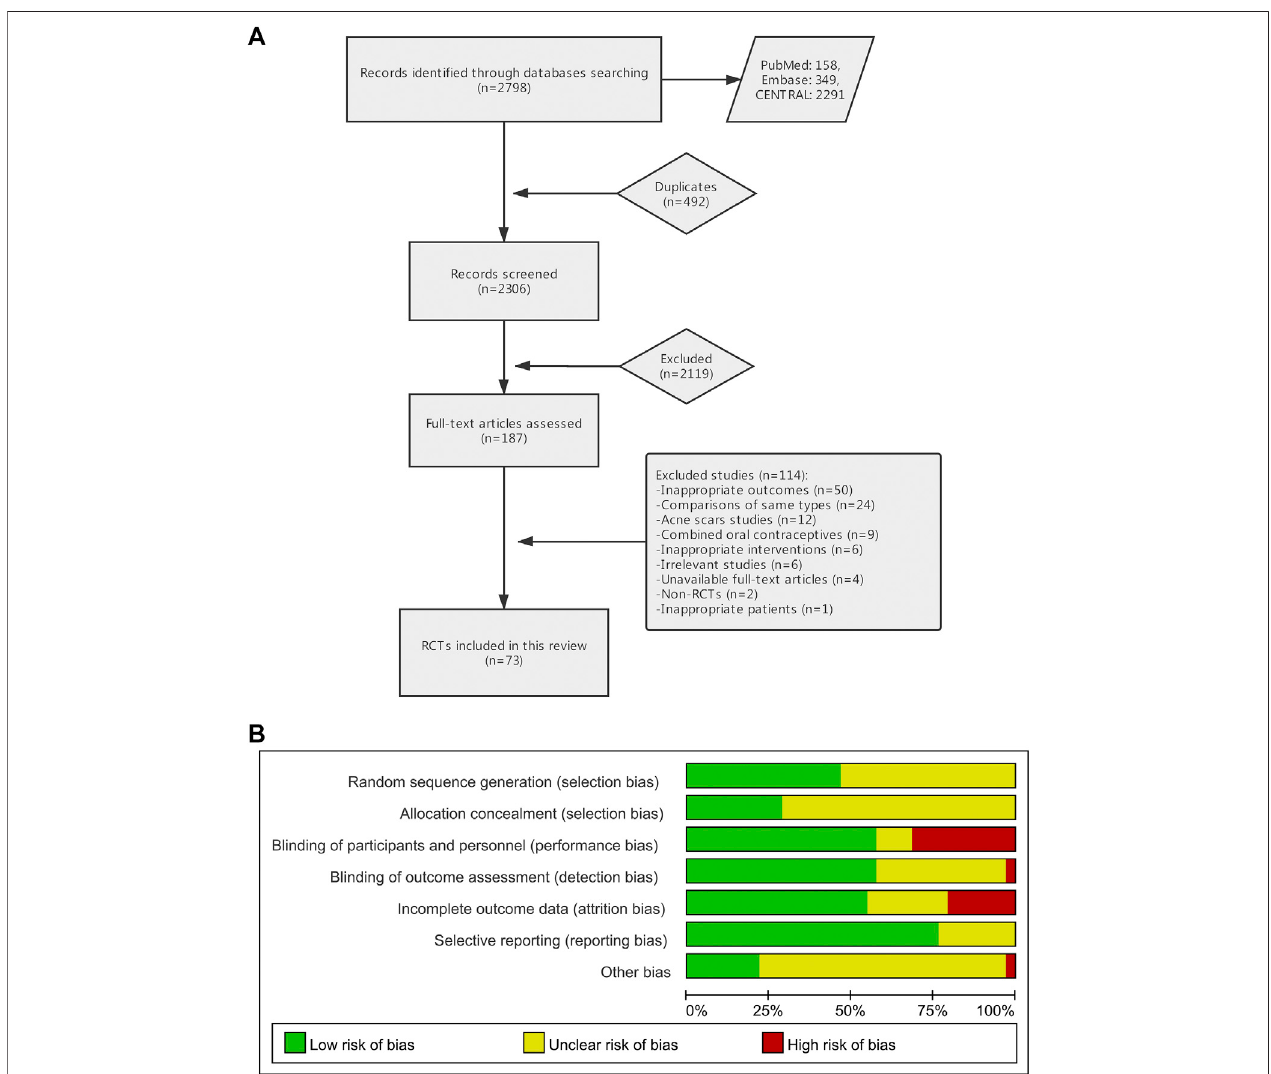
FIGURE 1 | (A) Flow diagram of selection of studies. (B) Risk of bias